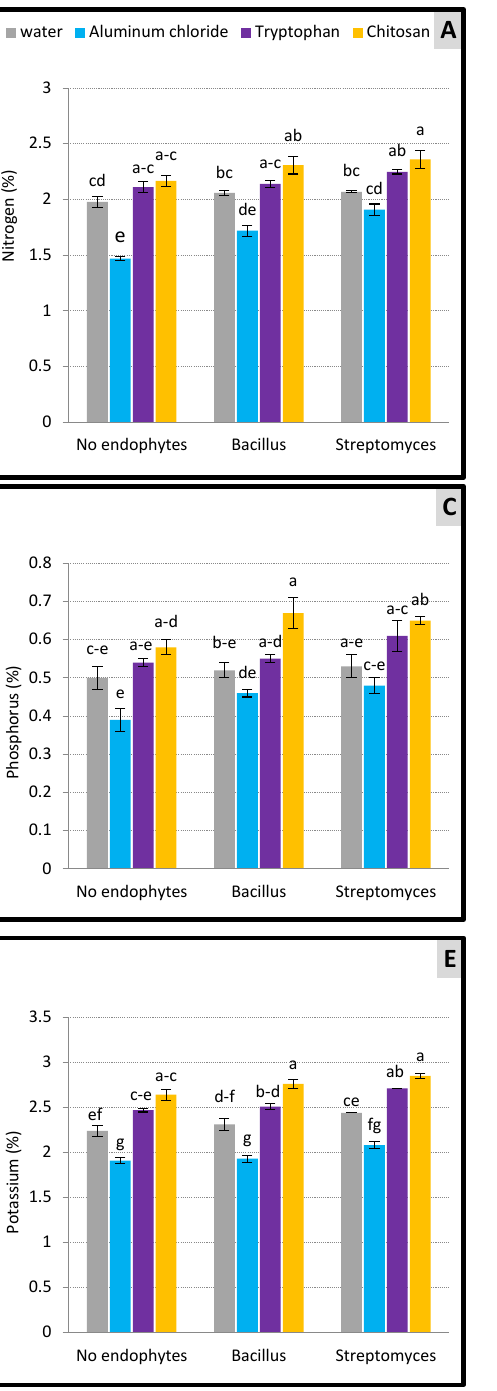
Figure 3. Interactive effect of endophytic microorganisms and abiotic elicitors on the percentage of ( A , B ) nitrogen, ( C , D ) phosphorus, and ( E , F ) potassium in periwinkle plant shoot in both seasons. Columns with the same letter in each chart are non-significantly ( p ≤ 0.05) different according to Tukey’s test. Means of five replicates are presented with ±SE.